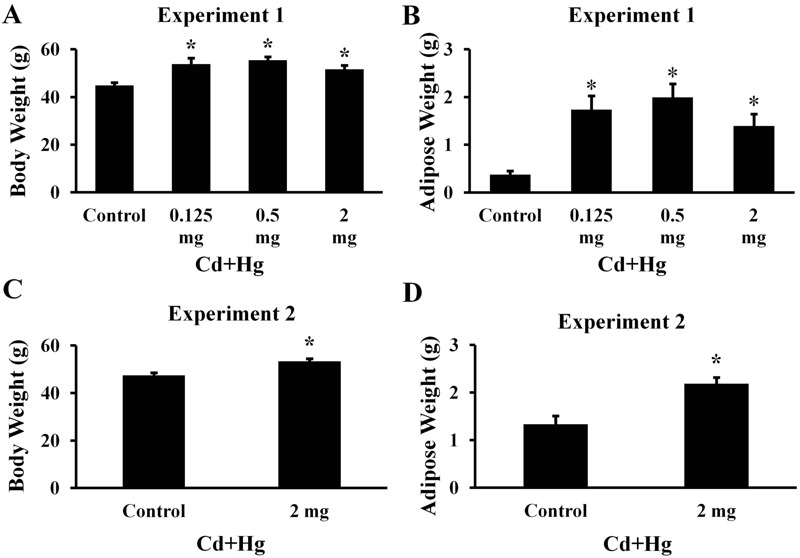
Body and adipose weights of male offspring from (A, B) Experiment 1 at 24 weeks of age and from (C, D) Experiment 2 at 25 weeks of age (*p < 0.05 compared with controls; n = 16 per treatment in Experiment 1; n = 19 for controls and n = 17 for treated offspring in Experiment 2). Left panels (A, C) show offspring body weights. Right panels (B, D) shows offspring abdominal adipose weights. The x-axis represents each treatment group. Note: Data are presented as mean ± SEM.